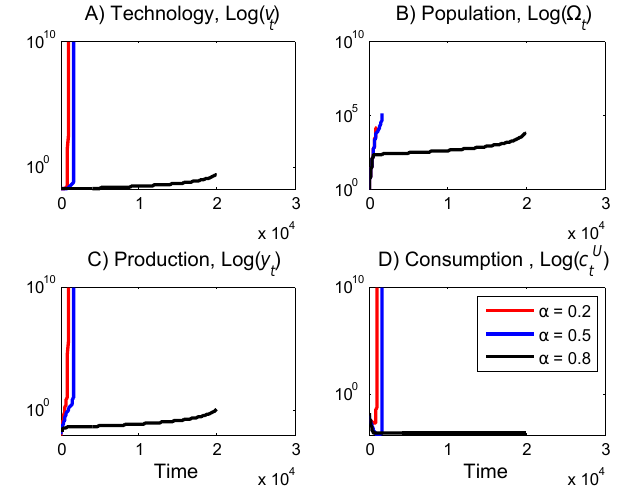
Figure 9. Case of a vulnerable society and highly productive skilled labor. Assumptions: η = 0.99 to represent a highly vulnerable so- ciety, low effectiveness of investment on technological change ( γ = 1 E − 3), the ratio of factors of production of skilled to un- − α − β = 2 and constant availability of water re- skilled worker, 1 β sources (i.e., k = 0).